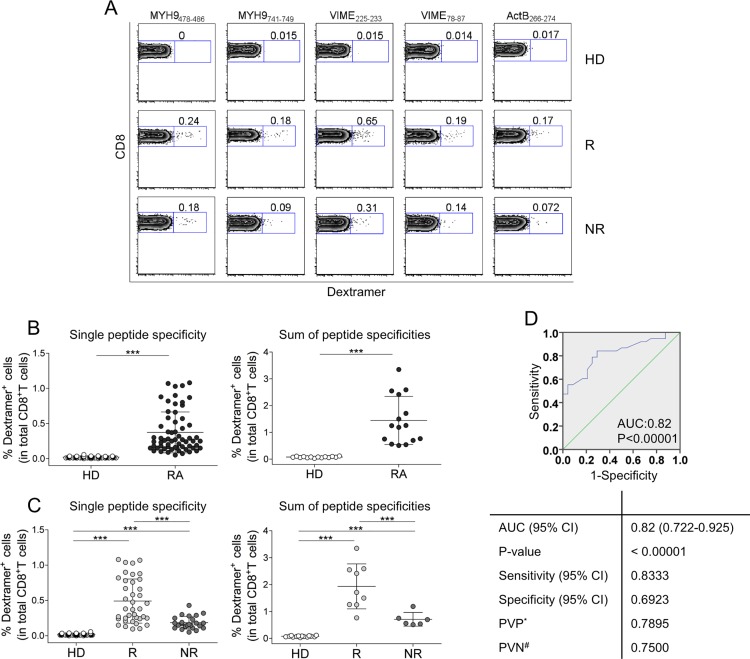
AE-specific CD8+ T cells predict RA patients who will (or will not) benefit from etanercept therapy (A-D).(A) Representative flow cytometry analysis of dextramer+CD8+ T cells specific to AE in an RA patient and an HD. Zebra plot analyses show the percentage of dextramer+CD8+ cells. (B) Percentage of dextramer+CD8+ cells in 14 HDs and 15 patients (each symbol represents the percentage of a single dextramer+CD8+ cell population) (left graph); sum of the percentages of all dextramer+CD8+ T cells detected in the single HD or patient (each symbol represents the sum of dextramer percentages in a single individual) (right graph). (C) Percentage of dextramer+CD8+ cells in 14 HDs, 9 Rs to etanercept, and 6 NRs (each symbol represents the percentage of a single dextramer+CD8+ cell population) (left graph); sum of the percentages of all dextramer+CD8+ T cells detected in the single HD, R, and NR (each symbol represents the sum of dextramer percentages in a single individual) (right graph). Analyses were performed at time 0 (before the start of therapy). Statistical analysis was performed with the Mann-Whitney test. **P < 0.001; ***P < 0.0001. (D) ROC curve analyses for R and NR patients. AUC = area under receiver operating characteristic curve. * = predictive value of positive test. # = predictive value of negative test.